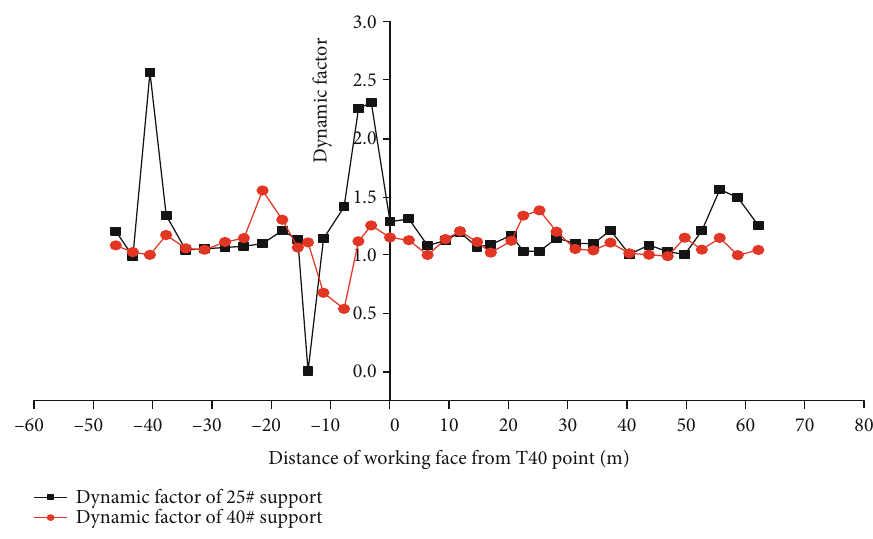
Figure 13: Variation curve of the support dynamic load